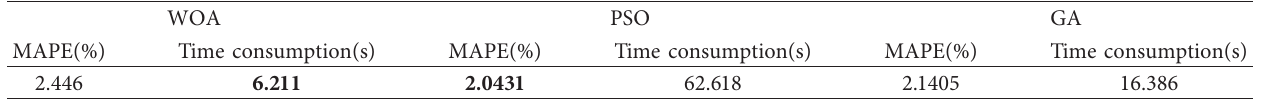
Table 3: The minimum MAPE and time consumption of WOA, PSO, and GA in Case 1. WOA